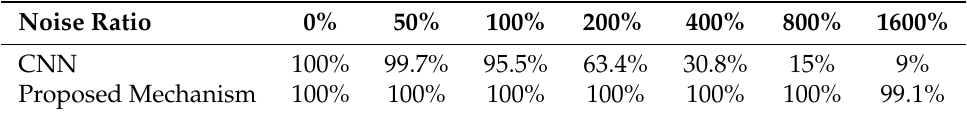
Table 3. Comparison of identification accuracy between CNN and proposed mechanism for 16 voxel object.